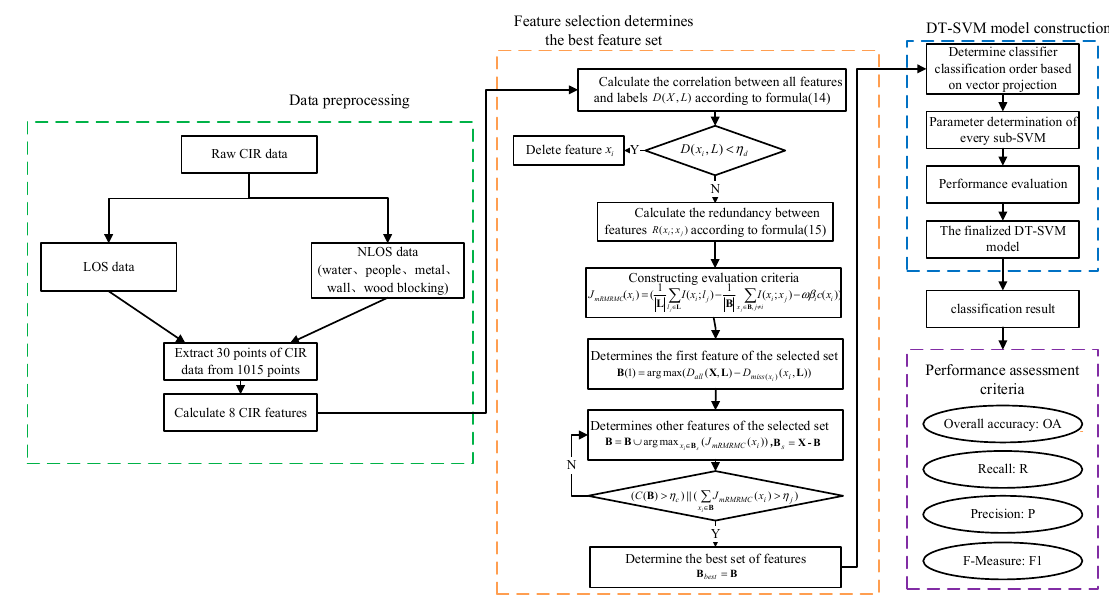
Figure 9. General diagram of algorithm flow.